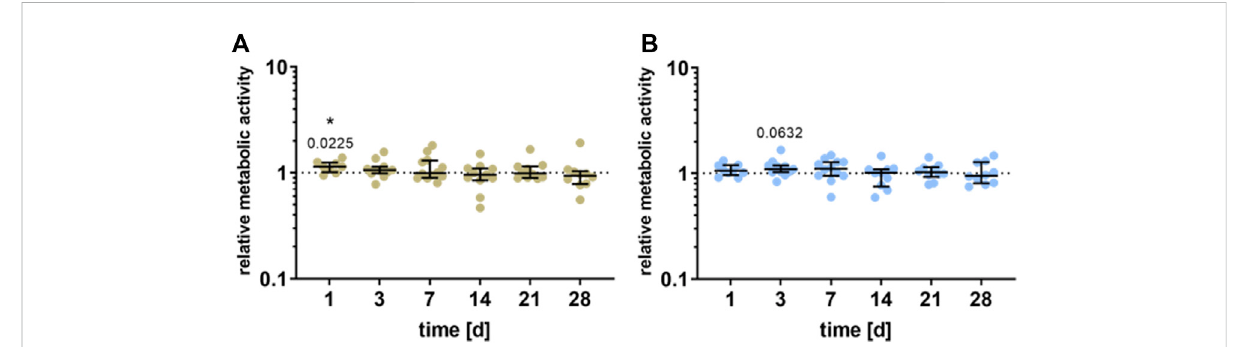
FIGURE 3 Metabolicactivityofhumanpre-osteoblastsundergoingelectrical stimulation. Pre-osteoblastswerestimulated over31 dayswithtwodifferent electric fi elds[ (A) higher electric fi eld:HEFand (B) lowerelectric fi eld:LEF] andwithout electrical stimulation(control). Analysis time pointswere1,3, 7,14,21,28,and31 dayswithassaysperformed20 hafterthelaststimulationintervalstarted.Metabolicactivityofstimulatedpre-osteoblastsrelated to the unstimulated control, determined via WST-1 assay. Results are shown as individual values with median and the 25%- and 75%-quartile to present the distribution of the total results [ n ≥ 5]. * p < 0.05: signi fi cant differences between the stimulated and control